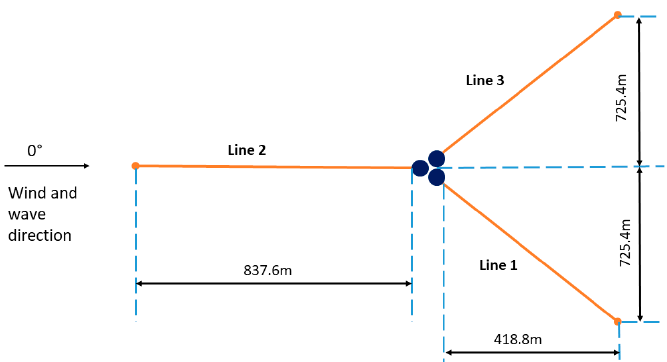
Figure 6. Wind/wave directions and mooring line orientations.